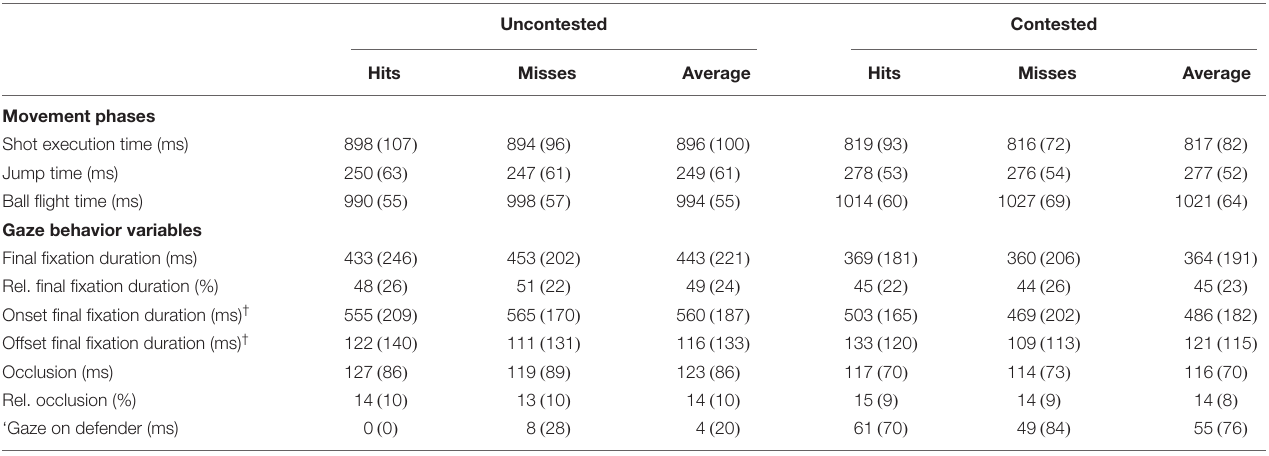
TABLE 1 | Mean ( SD ) duration of the movement phases and gaze behavior variables for hits and misses in the uncontested and contested conditions. For definitions of the phases and durations, we refer to the text (see section “Data Analyses”). Uncontested Contested